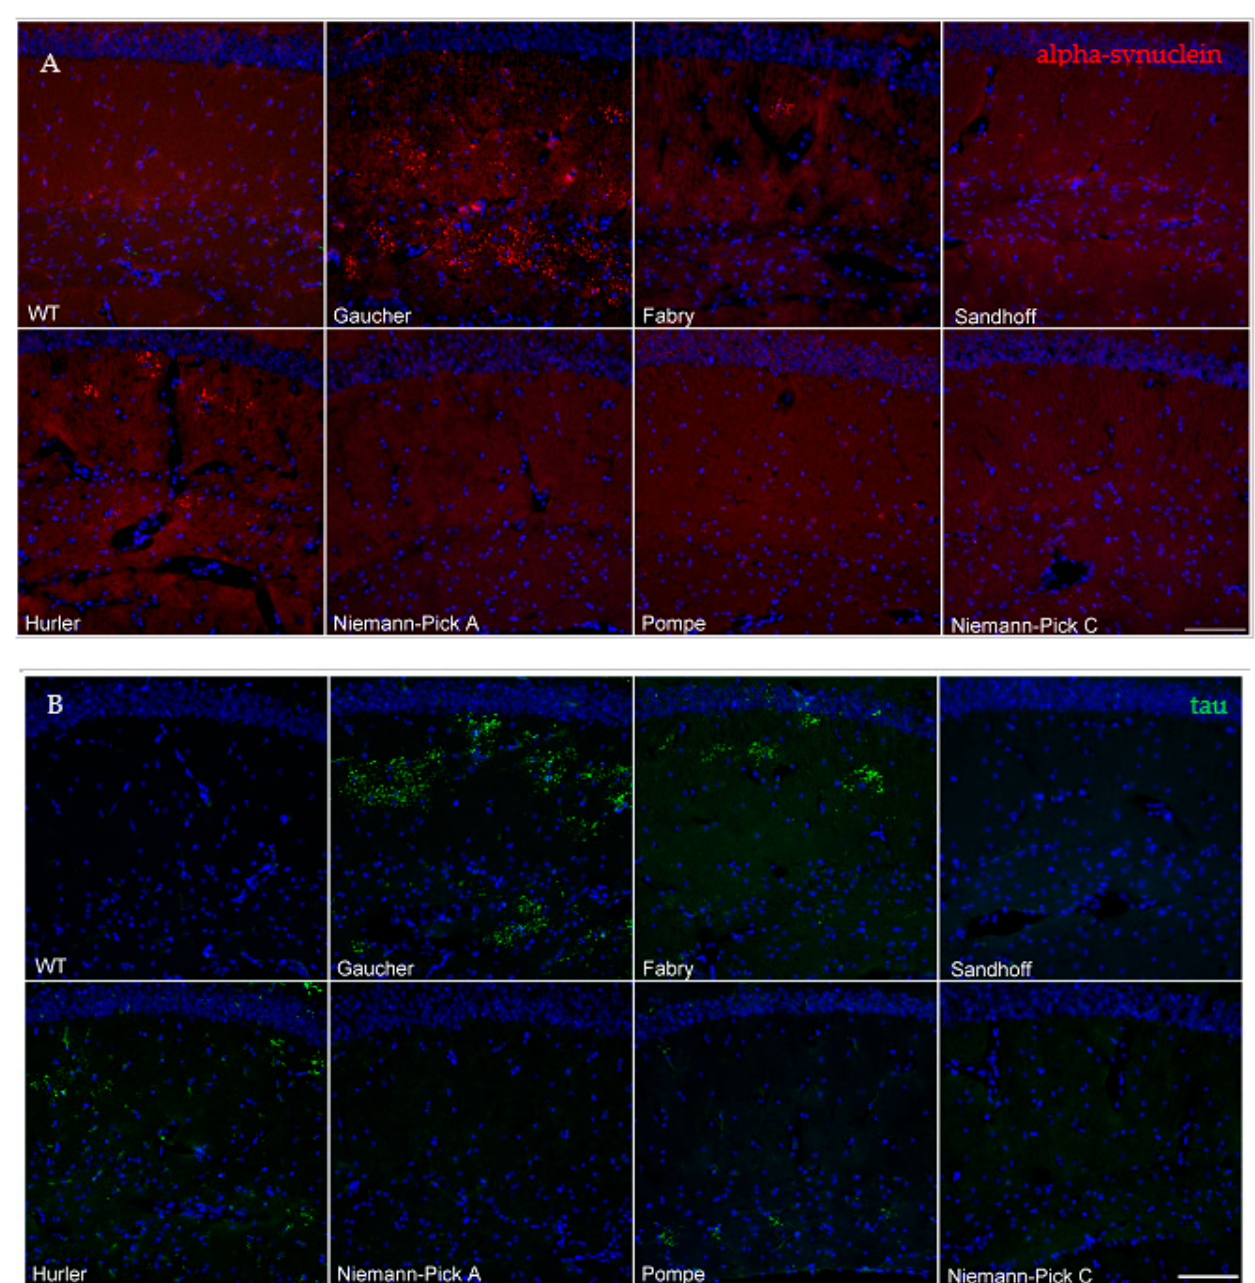
Figure 1. Gaucher, Fabry, Pompe and Hurler disease model mice exhibit aberrant proteinase K-resistant α -synuclein and/or tau immunoreactivity. The representative images show proteinase K-resistant α -synuclein immunoreactivity (red) in the hippocampi of wild-type or LSD mice ( A , see Table 1 for details). The WT animal was 12 months old at sacrifice. Alpha-synuclein pathology was undetected in wild-type, Sandhoff, Niemann–Pick A, Pompe and Niemann–Pick C mice. Representative images from hippocampal tau immunoreactivity (green) revealed aberrant tau accumulation in the Gaucher, Fabry, Hurler and Pompe mice ( B ). Abnormal tau foci were nearly absent in the Sandhoff, Niemann–Pick A and Niemann–Pick C mice. Nuclei are shown in blue with DAPI counterstaining (scale bar, 100 μ m). 3.2. Mouse Models of Gaucher, Fabry, Hurler and Pompe Disease Display a Diverse Distribution of Aberrant Protein Aggregation, Including Tau Tau and α -synuclein are partially unfolded proteins that can form toxic oligomers and abnormal intracellular aggregates under pathological conditions. α -synuclein pathol- ogy frequently co-occurs with tau and other microtubule protein inclusions in the brains